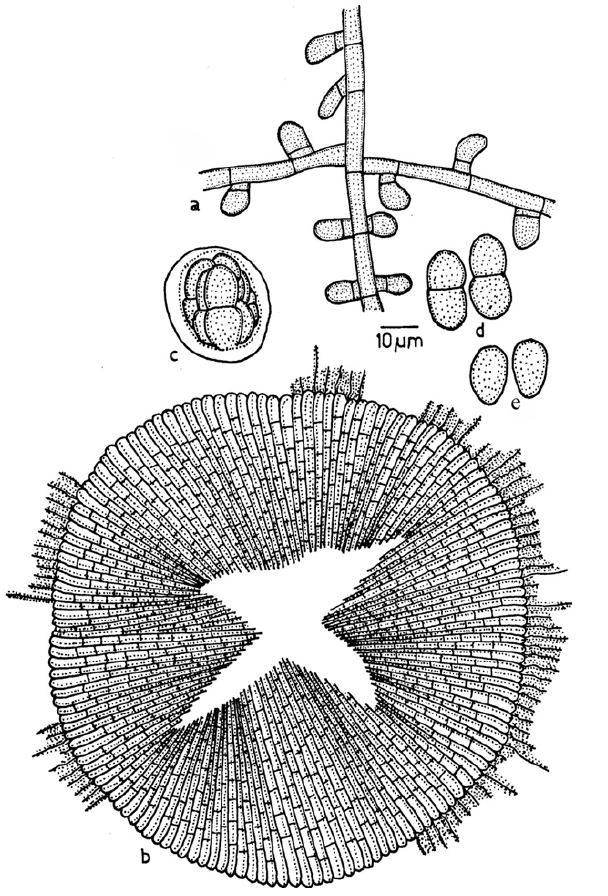
Figure 143. Asterina gamsii a - Appressorium; b - Thyriothecium; c - Ascus; d -